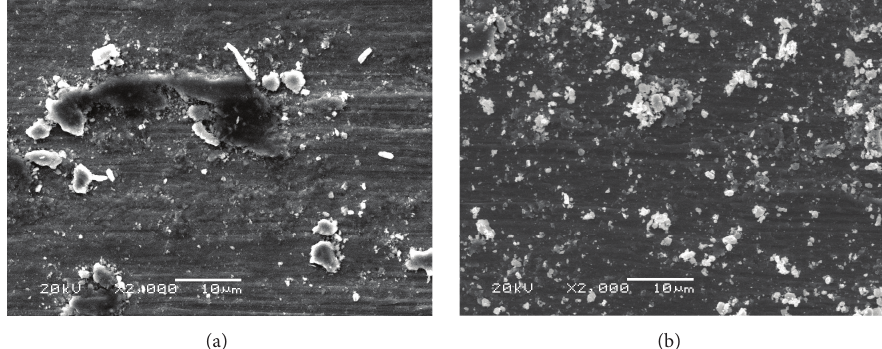
Figure 6: SEM morphologies of the worn surfaces of Ni-Ti coatings (a) before heat treatment and (b) after heat treatment at a load of 4.0 N.